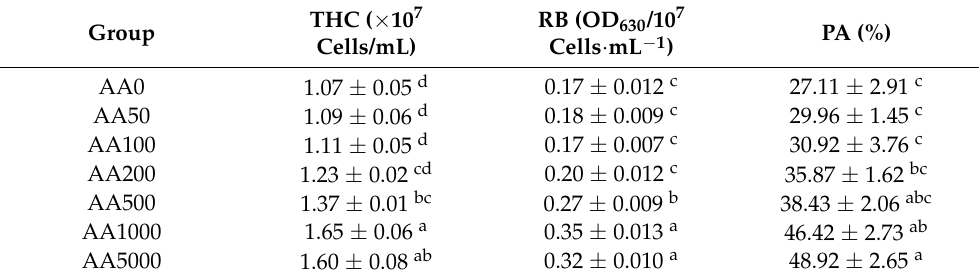
Table 3. Effects of dietary ascorbic acid on total hemocyte counts (THC), respiratory burst (RB) and phagocytic activity (PA) in abalone ( Haliotis discus hannai ) hemolymph after a 100-day feeding trial. THC ( × 10 7 RB (OD 630 /10 7 Group PA (%) Cells/mL) Cells · mL − 1 ) AA0